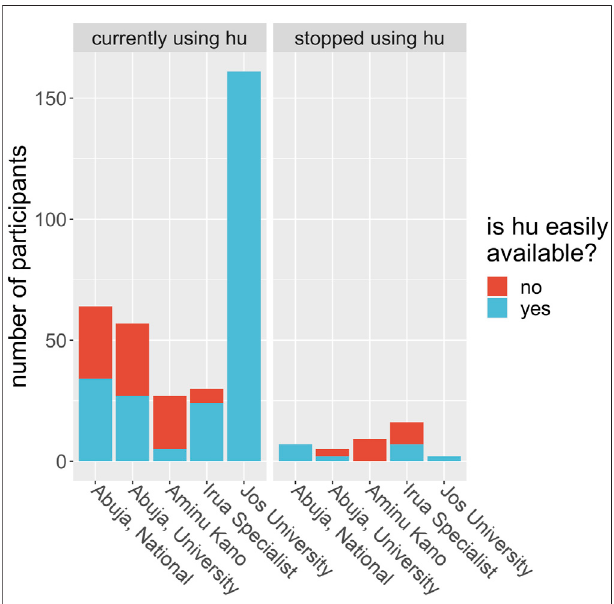
FIGURE3| Studyparticipantswereaskedifhydroxyurea(hu)waseasily available to them at the time of the study. Each bar shows the number of participants at each study center (x-axis) who responded yes, it is easily available (blue) or no, it is not easily available (red) given that they were either currently using hu (left plot) or did use hu but had stopped at the time of thequestionnaire(rightplot).Theblueandredbarsarestackedontopofeach other, so the height of each bar represents the total number of patients at that